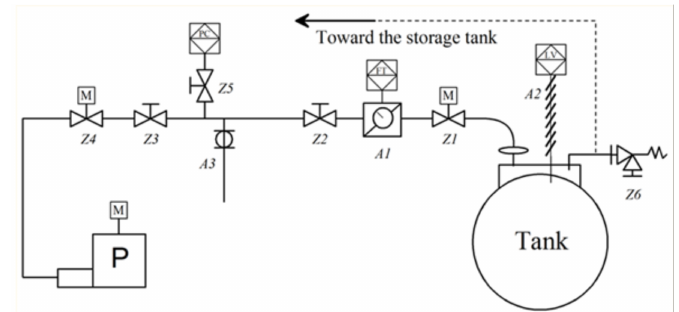
Figure 1. Technological diagram of fillers for sulfuric acid (VI), where: A1—flow measurement, DN 65; A2—emergency level sensor; A3—ball valve, DN65; P—flow meter, DN 65; Z1—flap valve,